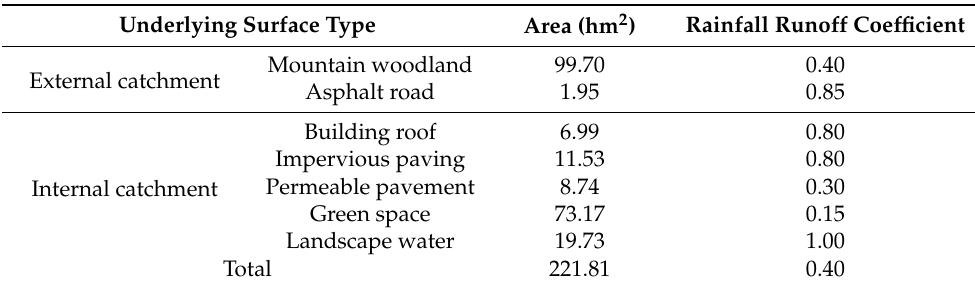
Table 1. Runoff coefficient of catchment area.